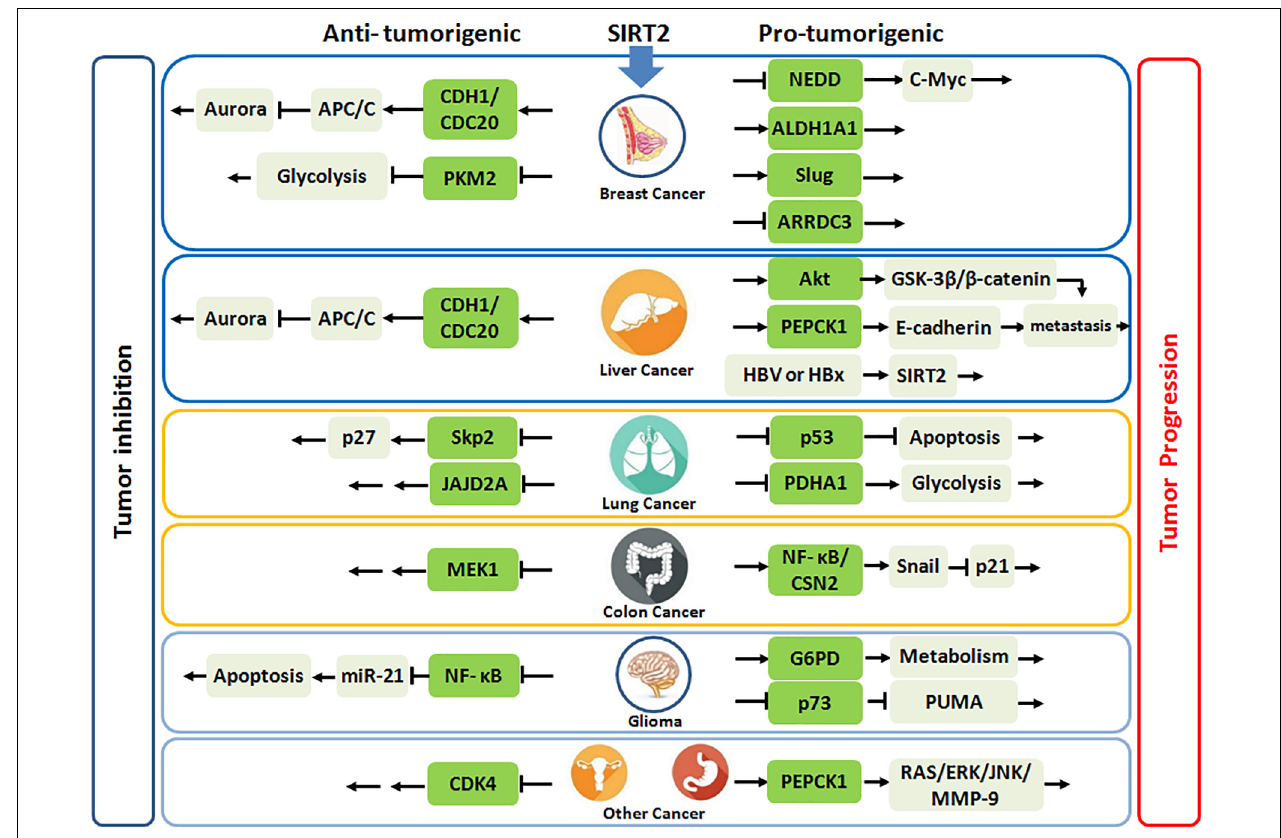
FIGURE 1 | SIRT2 plays the anti-tumorigenic or pro-tumorigenic roles in various malignances. Highlighted green frames represent substrates or partners of SIRT2.